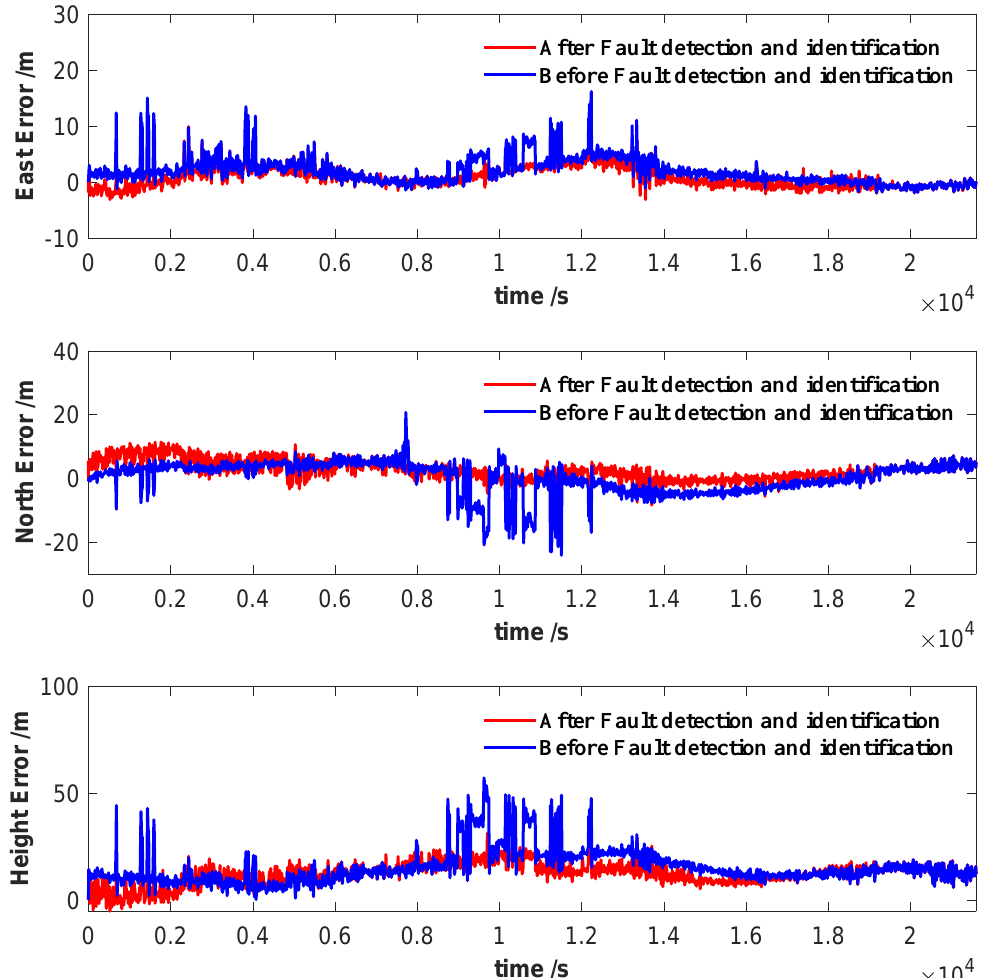
Figure 4. Comparison the results of the position error: before and after fault detection and